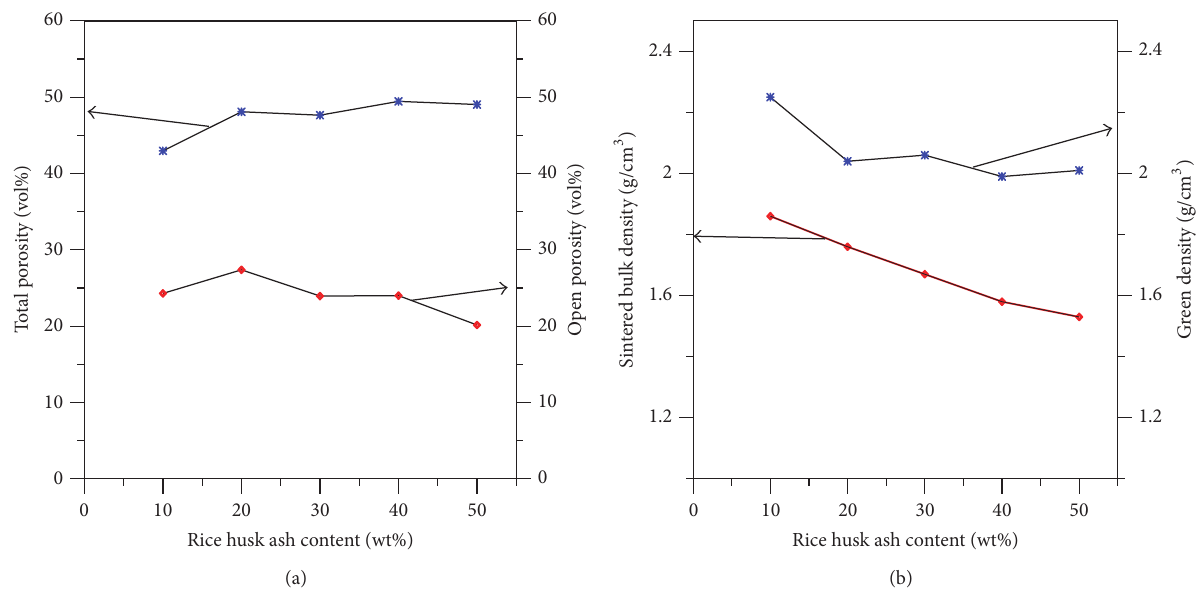
Figure 4: (a) Trend of total porosity and open porosity with increases in the content of rice husk ash; (b) trend of sintered bulk density and green density with increases in the content of rice husk ash. All samples were sintered at 1600 ∘ C for 2 hrs.